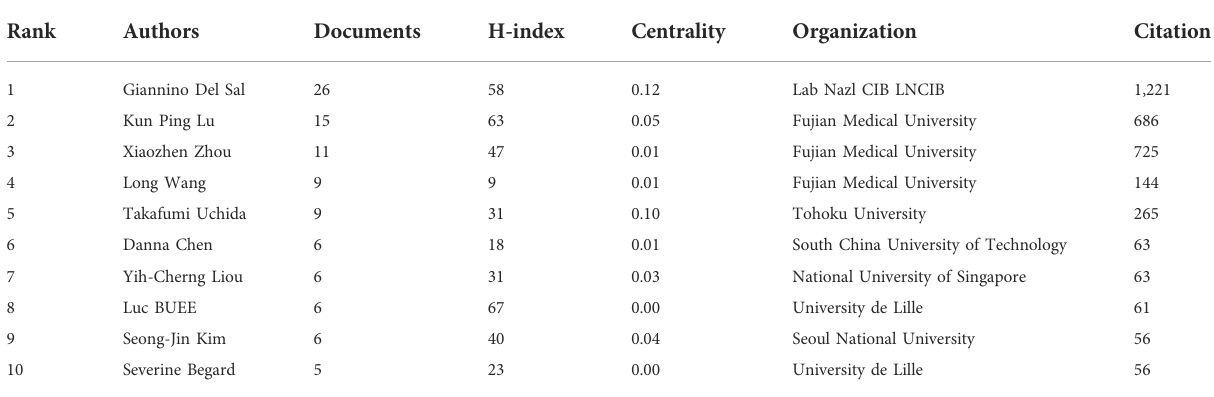
TABLE 4 Top 10 most productive authors.